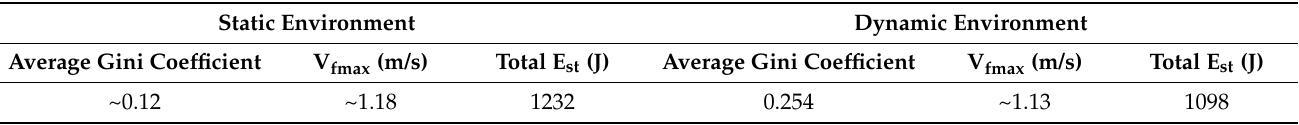
Table 4. Energy-balanced travel based on the Gini coefficient.